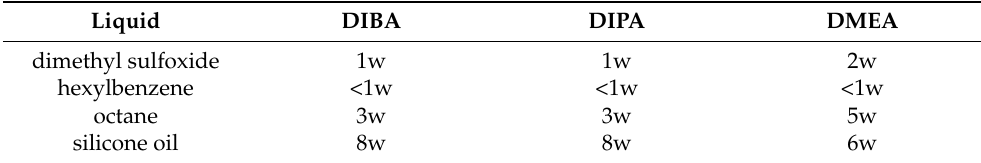
Table 2. Stabilities a at room temperature of gels of 2 wt% gelators in various